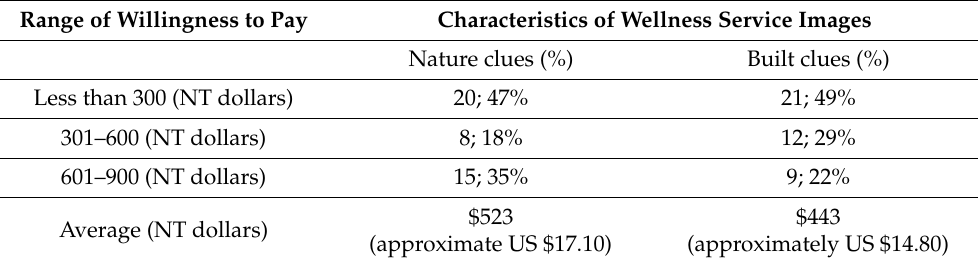
Table 3. Comparison of the amount older customers were willing to pay. Range of Willingness to